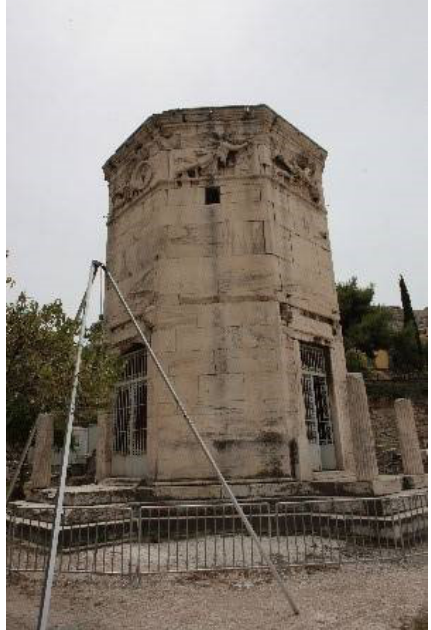
Figure 8: The special tripod for hoisting the camera